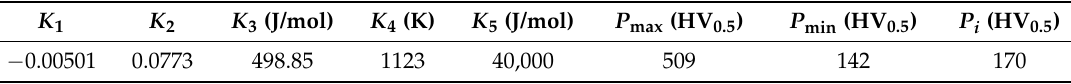
Table 2. Material constants of boron steel in the quench factor analysis